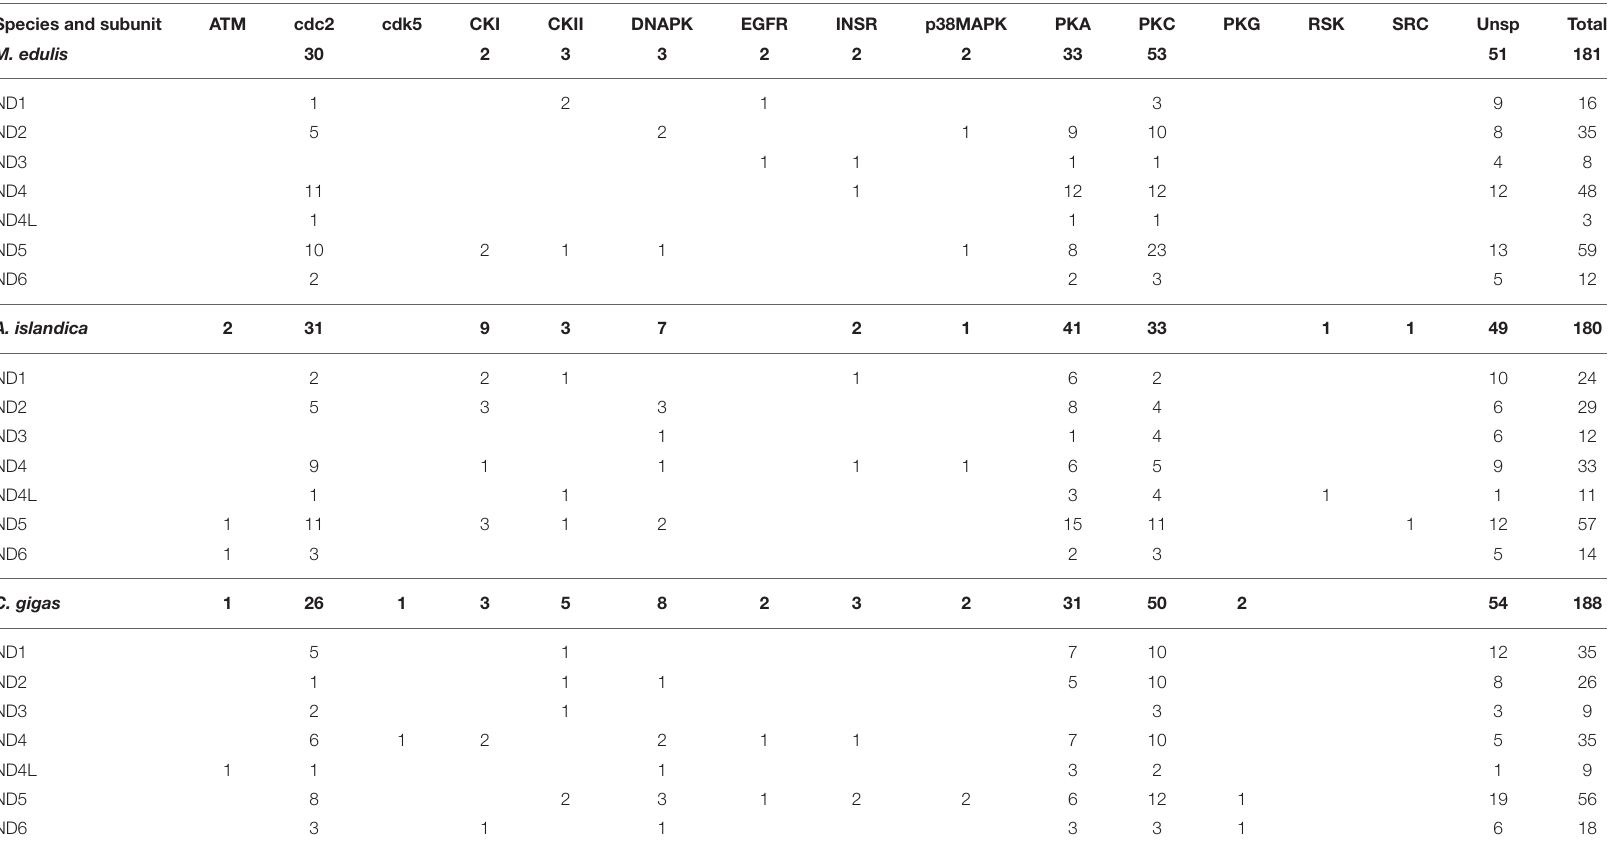
TABLE 2 | Distribution of the predicted phosphorylation sites on the core mitochondrial subunits of Complex I in the three studied species. Species and